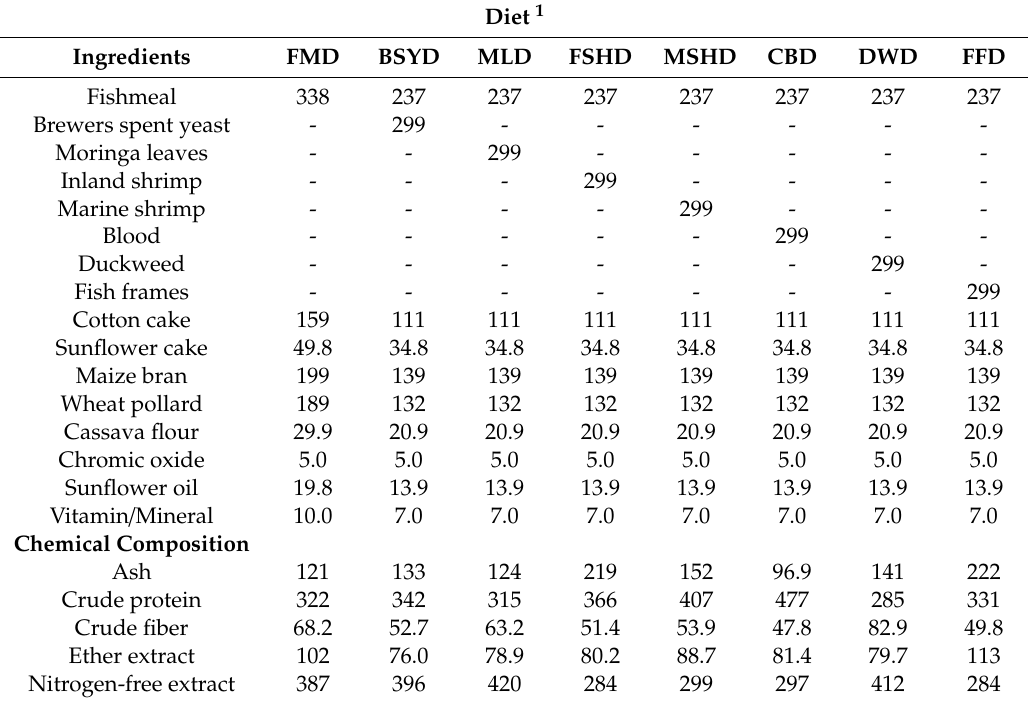
Table 2. Ingredients (g / kg) and chemical composition (g / kg DM) of reference diet (FMD) and test